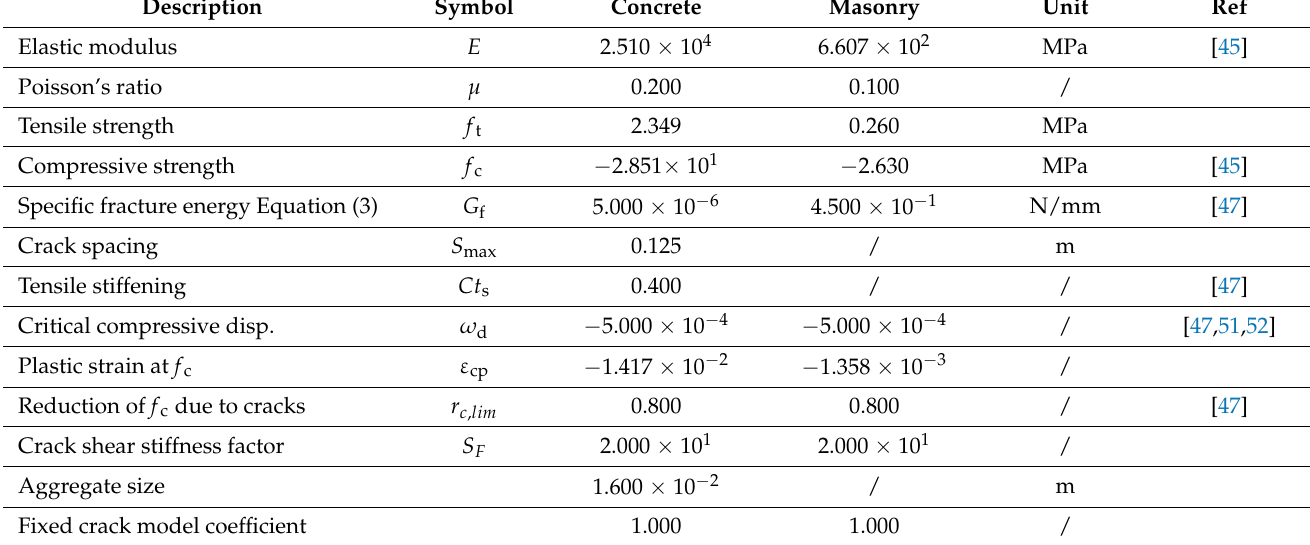
Table 4. Initial properties of the fracture–plastic constitutive model.